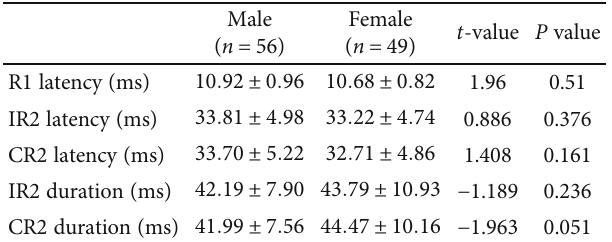
Table 2: Di ff erences in blink re fl ex between di ff erent sexes in patients with